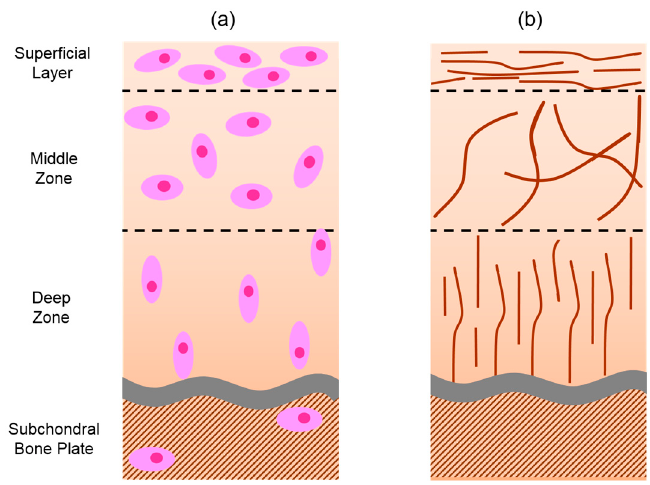
Figure 1. Orientation and structure of ( a ) chondrocytes; and ( b ) collagen fibres within the different layers of the articular hyaline cartilage.